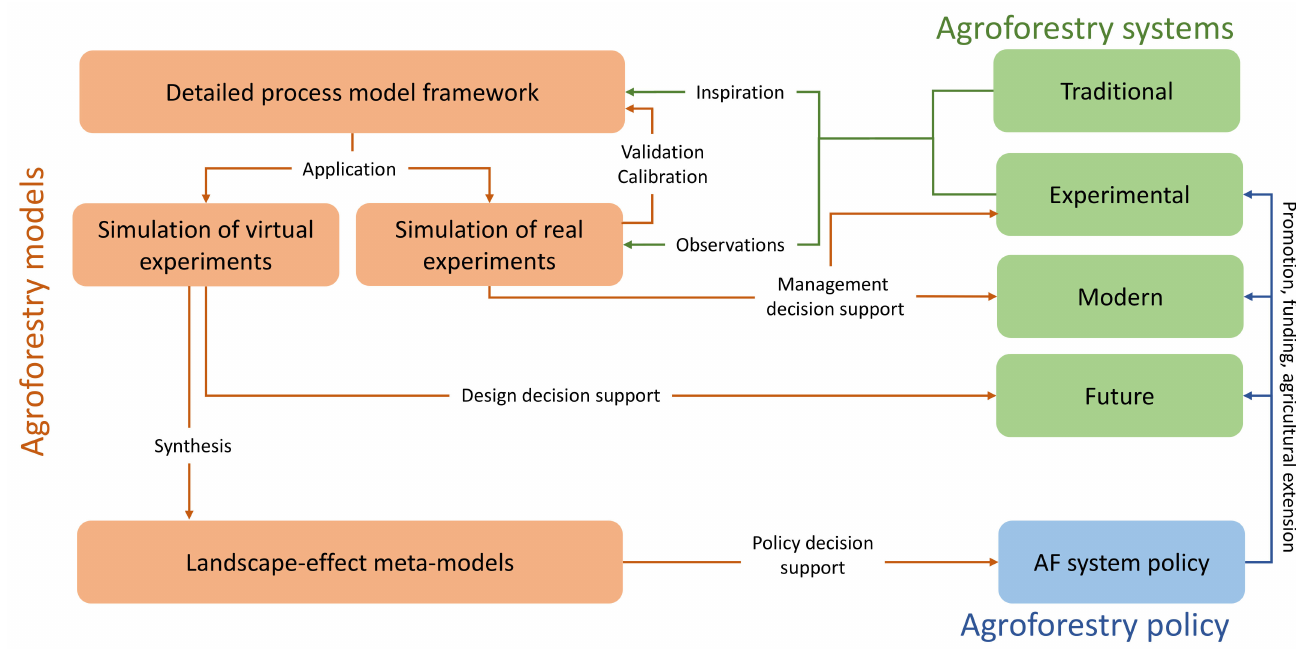
Figure 1. Relationships and feedbacks between established agroforestry systems, models and policy. Agroforestry systems are divided into traditional smallholder systems that have developed at local or regional scale over long timespans, experimental systems managed by research institutions, modern operative systems managed by farmers for production, and not yet established future systems in a model-guided design phase towards optimized contributions to